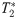
Simulation scheme.A gradient echo measurement is used to estimate a T2* map. Using the T2* anatomy and rescaling the values to an appropriate range, a susceptibility distribution is generated. Random susceptibility structures are added and dipole convolution generates the susceptibility-induced field map and a local reference. External disturbances are introduced as randomised spherical harmonic functions and noise is added. After BFR correction the results are compared to the reference field.